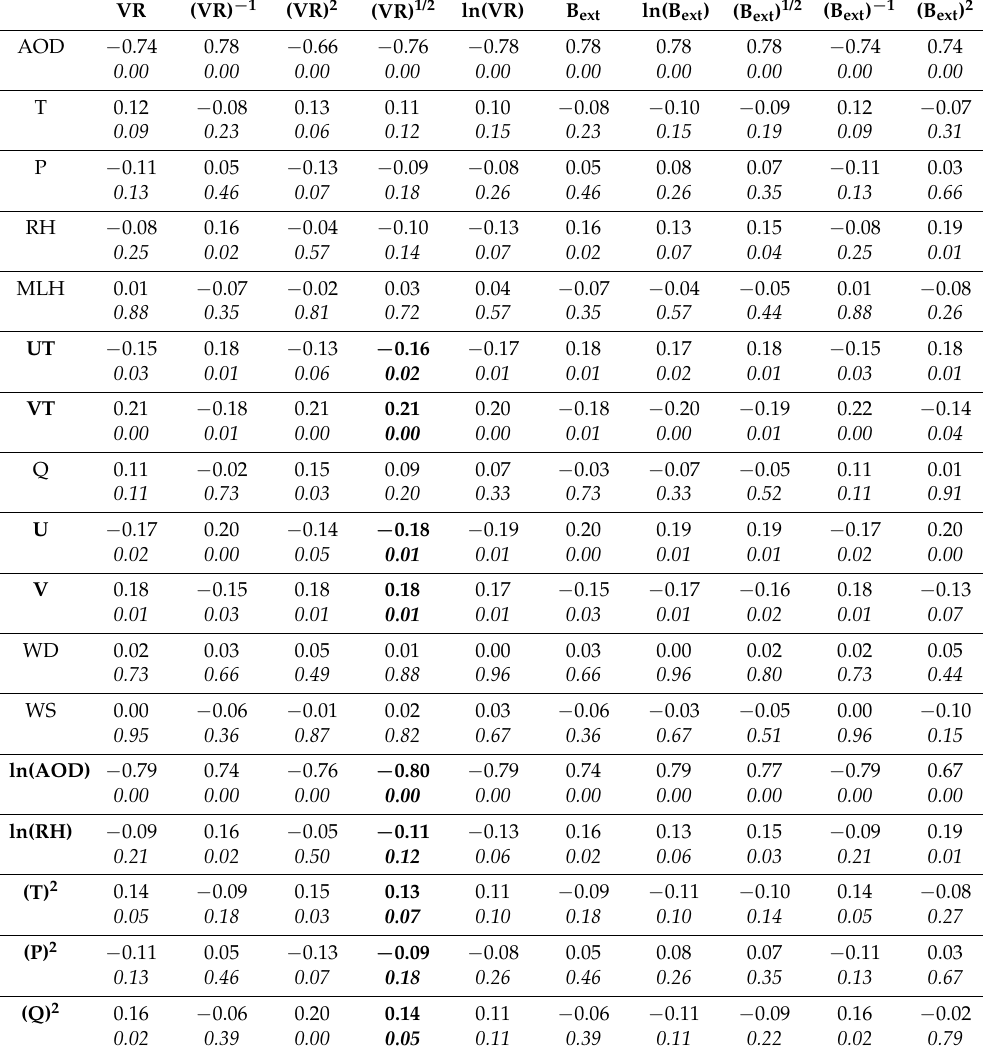
Table 2. Correlation matrix for independent and dependent